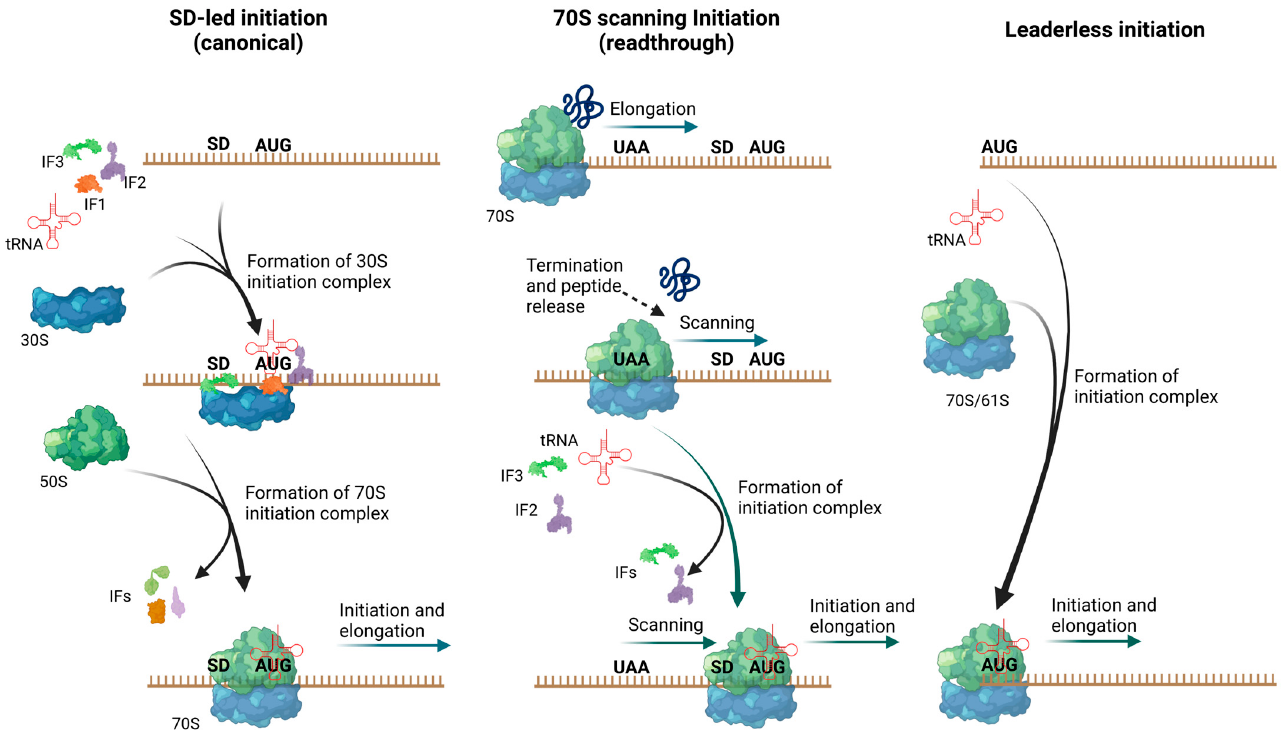
Figure 1. Mechanisms of translation initiation in bacteria. In bacteria, translation can be initiated by three mechanisms. Shine-Dalgarno (SD)-led translation ( left ), 70S scanning ( center ), and leaderless initiation ( right ). As shown, although most of the components are similar between these three mechanisms, translation initiation factors (IFs) have different roles. Arrows indicate either movement on mRNA or binding/unbinding of translation machinery components. Figure created with BioRender.com. Model of IF1 is based on pdb 1AH9 [15] and model of IF2 on pdb 4b48 [16]; model of IF3 was obtained from AlphaFold (P0A707) [17,18].